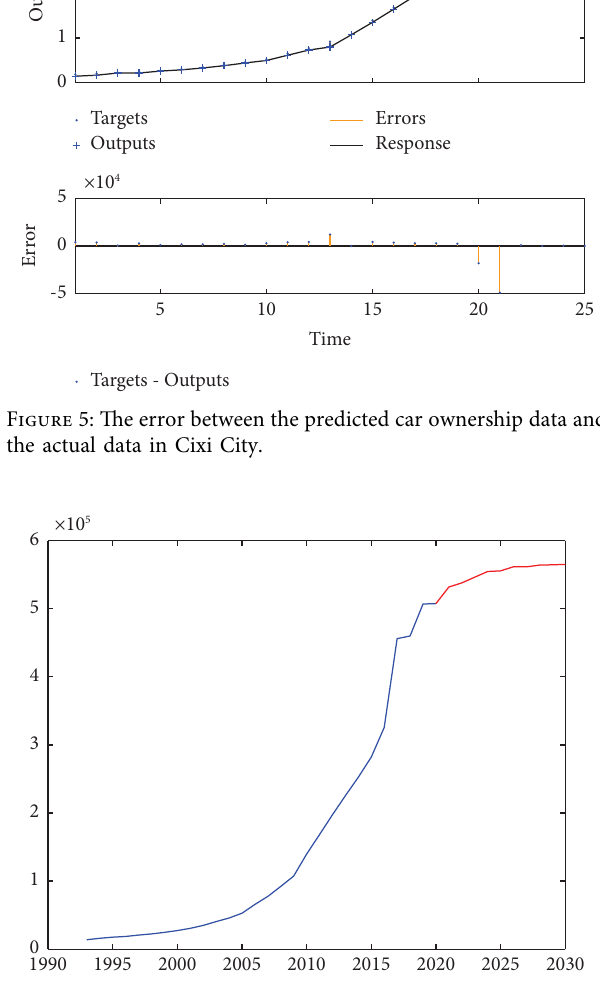
Figure 6: Forecast of vehicle ownership quantity in